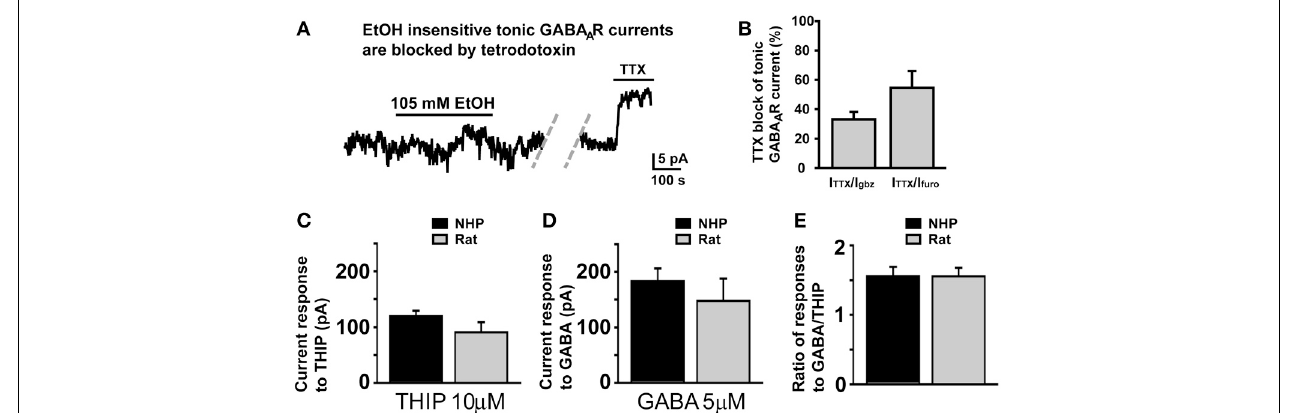
expressed as the percent of the tonic GABA A R current blocked by the broad spectrum GABA A R antagonist, GABAzine (10 μ M, left bar) or the α 6 specific antagonist, furosemide (100 μ M, right bar), n = 7 and 6 GCs respectively from two animals. (C–E) Plots of mean current induced by THIP (10 μ M, C ), GABA (5 μ M, D ), and the ratio of the amplitudes of those responses in individual GCs (E) . For each plot, data from NHPs and SDRs are plotted in black and gray respectively ( n = 4–10 GCs each from 2 to 3